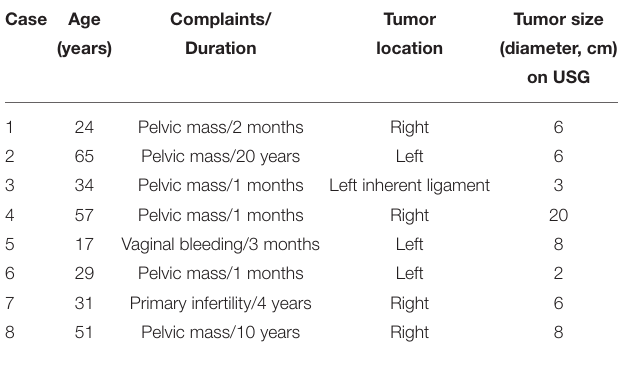
TABLE 2 | Surgical and histopathological results of our eight